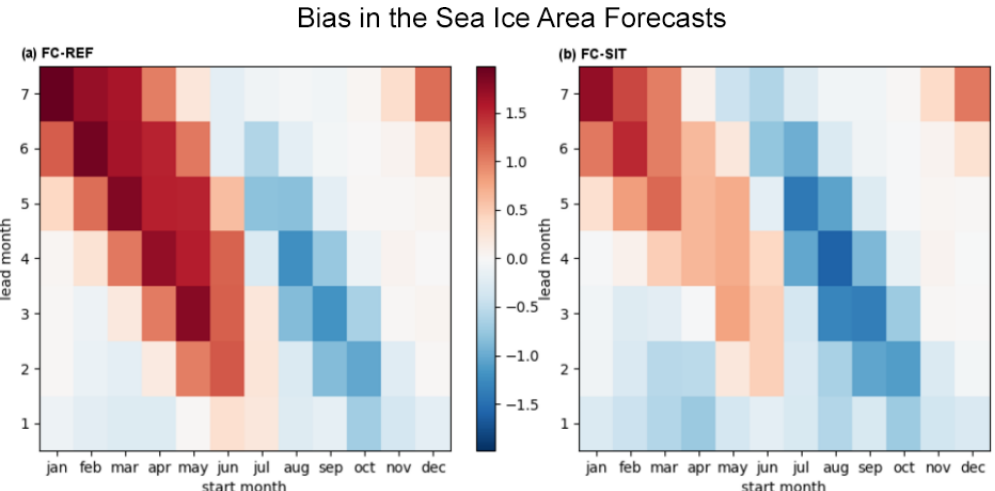
Figure 5. Bias in the forecast of pan-Arctic sea ice area ( × 10 6 km 2 ) with respect to ORAS5 as a function of start and lead month for 2011– 2016 (a) in the reference reforecast FC-REF and (b) in the SIT-initialized reforecast FC-SIT. Red colour denotes over-prediction of sea ice area, and blue colour denotes under-prediction.